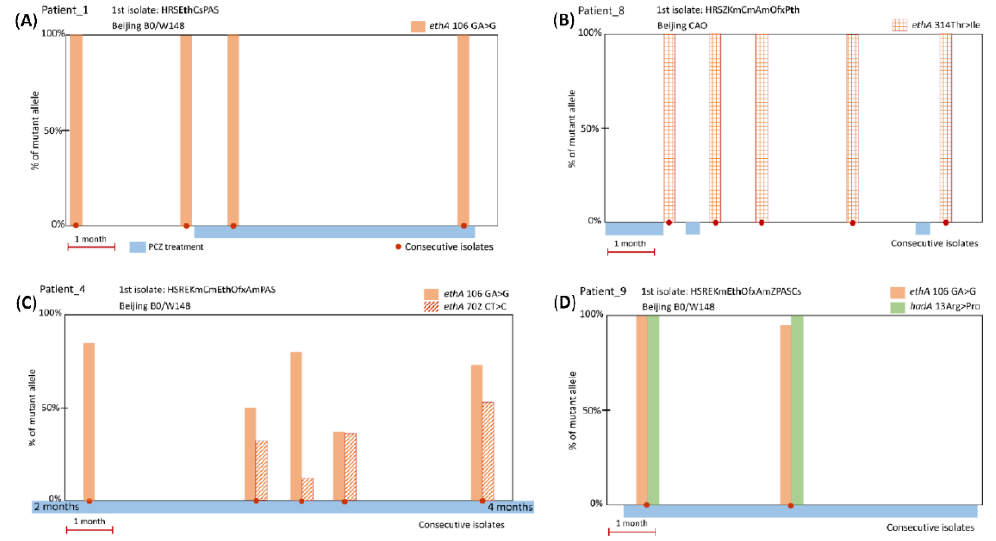
Figure 1. Representative examples of timelines of PCZ treatment, and ethA or hadA mutations in M. tuberculosis isolates. ( A ) Frameshift ethA 106 GA > G mutation present in PCZ pre-treatment isolates